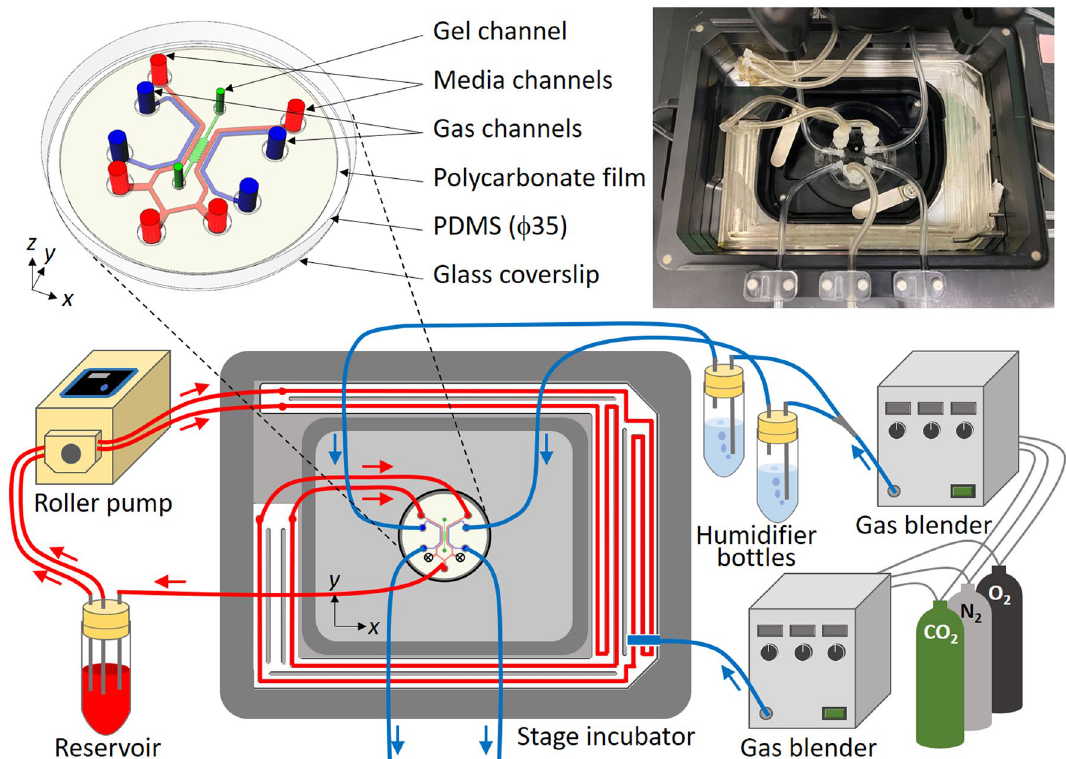
Figure 1. The experimental platform, consisting of a microfluidic device, a flow channel placed in a stage incubator to control the oxygen concentration in a cell culture medium, a roller pump, a reservoir for the cell culture medium, gas blenders, and humidifier bottles. The oxygen and carbon dioxide concentrations of the gas mixtures were adjusted by mixing with nitrogen. The gas mixtures were humidified by bubbling through the humidifier bottles before being supplied to the gas channels in the microfluidic device. The cell culture medium was circulated by the roller pump: medium was drawn from the reservoir, supplied to the flow channels and the media channels in the microfluidic device, and then returned to the reservoir. Red and blue arrows indicate the flow directions of the cell culture medium and gas mixtures, respectively. The upper right figure is a photograph of the device and the flow channel placed in the stage